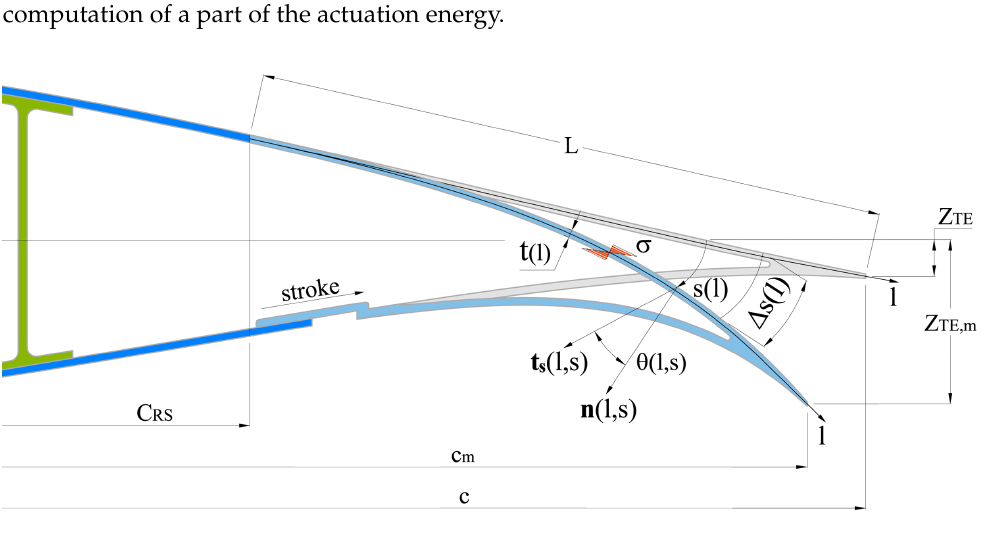
Figure 4. Mathematical quantities and geometrical parameters adopted for the design optimization of morphing